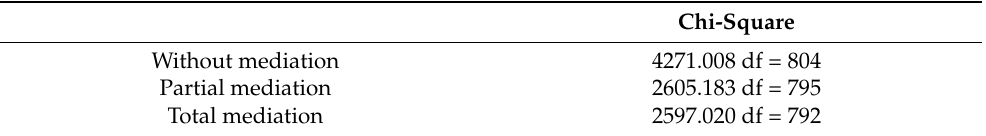
Table 9. Mediation Models.